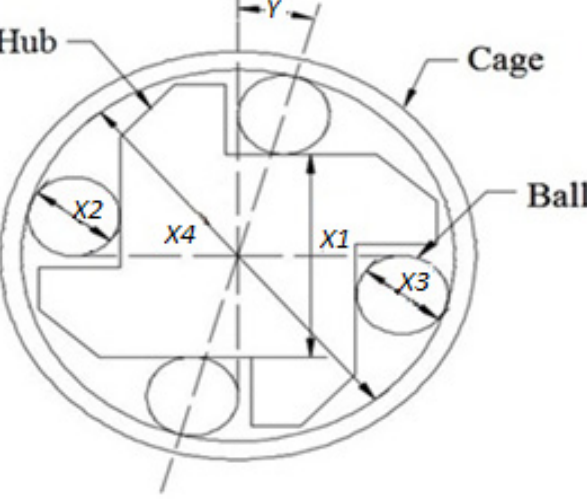
Figure 1. Overrunning clutch assembly.